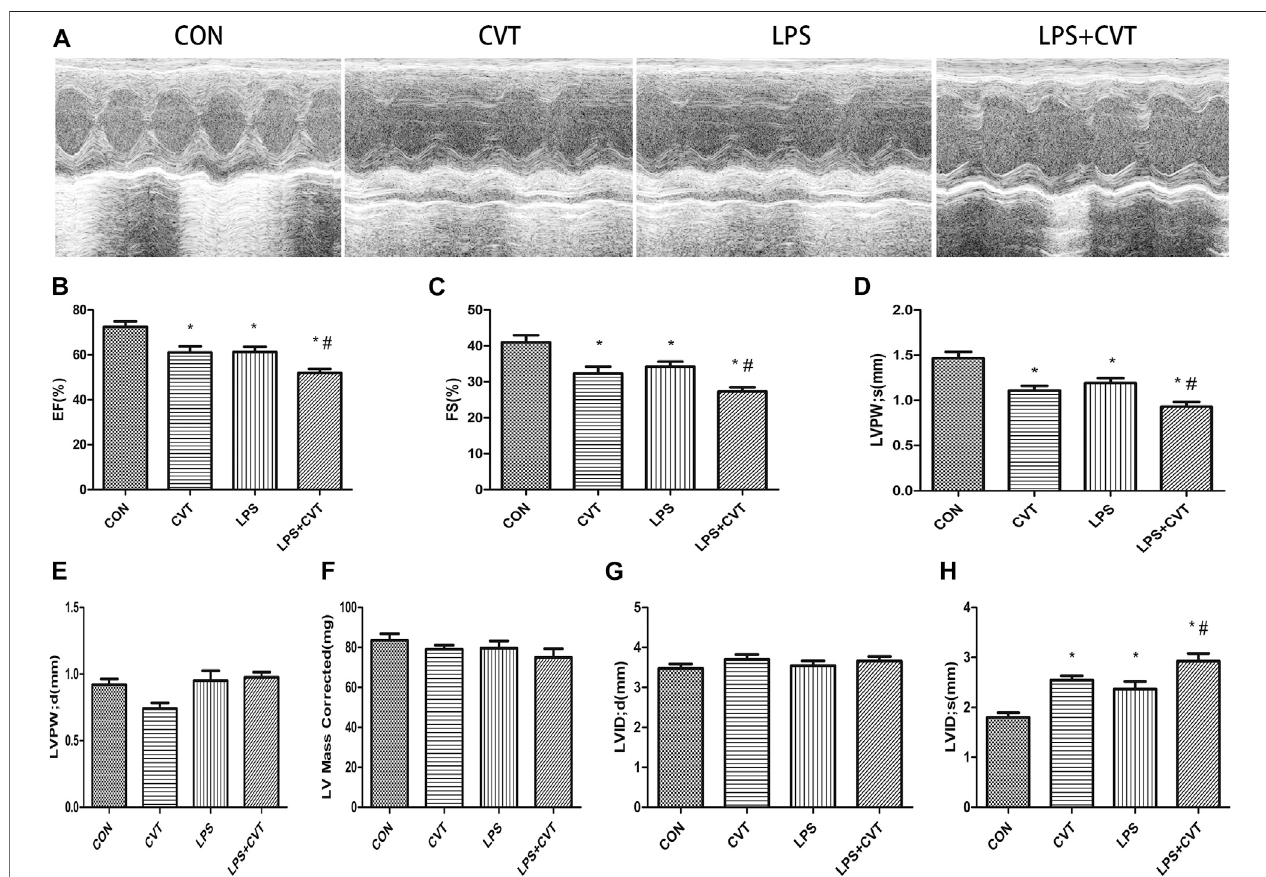
FIGURE2| Cardiacfunctioninlipopolysaccharide(LPS)-treatedmice. (A) Representativeechocardiographicimagesfromfourmousegroups. (B) Ejectionfraction (EF). (C) Fractionalshortening(FS). (D) Leftventricularposteriorwallthicknessinsystole(LVPWs). (E) Leftventricularposteriorwallthicknessindiastole(LVPWd). (F) Left ventricular mass. (G) End-diastolic left ventricular internal diameter (LVIDd). (H) End-systolic left ventricular internal diameter (LVIDs). Data are the mean ± standard error of the mean. n (cid:1) 6 mice/group. Statistical analyses were performed by one-way analysis of variance, followed by Tukey ’ s post hoc test for multiple comparisons. * p < 0.05 vs. control (CON); # p < 0.05 vs.